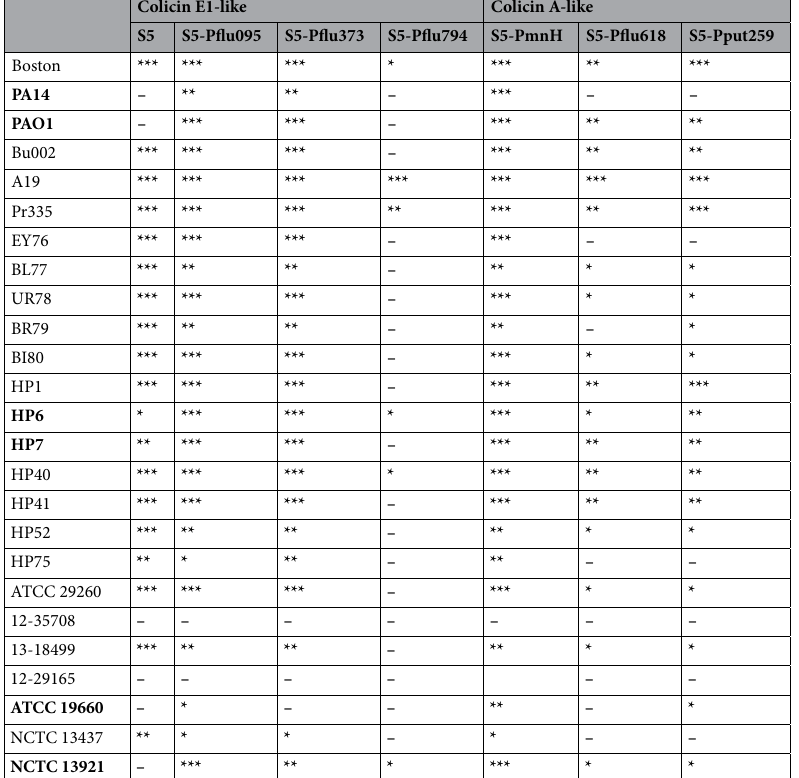
Table 1. Activity of chimeric pyocins on panel of P. aeruginosa strains as determined in agar disc-diffusion assay. *Activity detected only with 30 μg of protein, **activity detected with 3 μg of protein, ***activity detected with 0.3 μg of protein. Pyocin S5 killing and immunity protein genes-containing strains are in